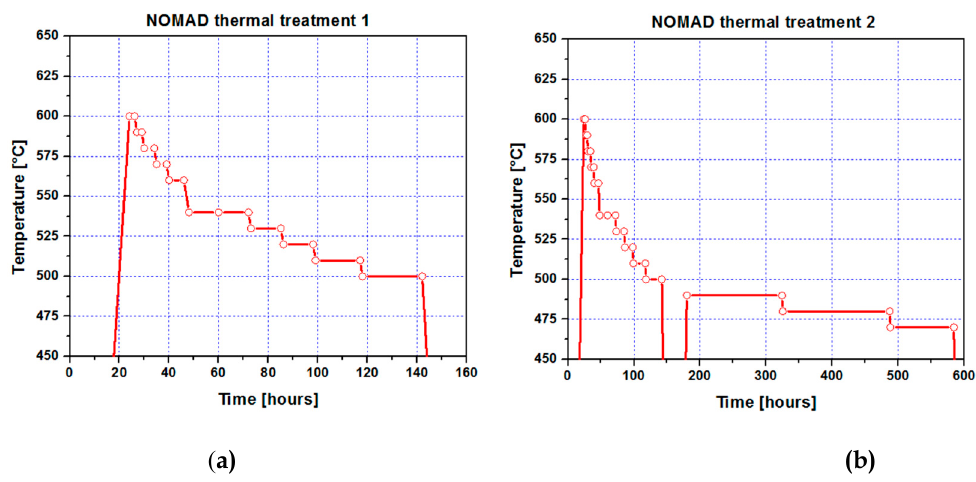
Figure 1. ( a ) Step cooling ”thermal treatment 1”; ( b ) step cooling ”thermal treatment 2”.